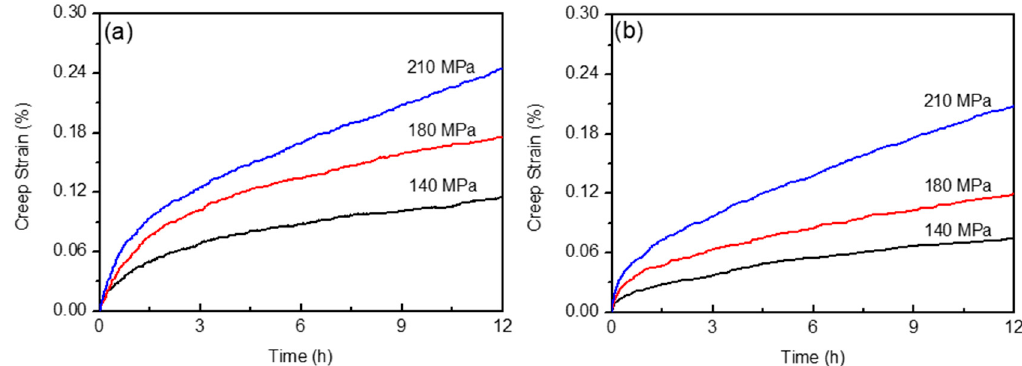
Figure 6. Creep behaviors of the 0 h- ( a ) and 12 h- ( b ) preaged AA2524 under the applied stress of 140 MPa, 180 MPa, and 210 MPa.